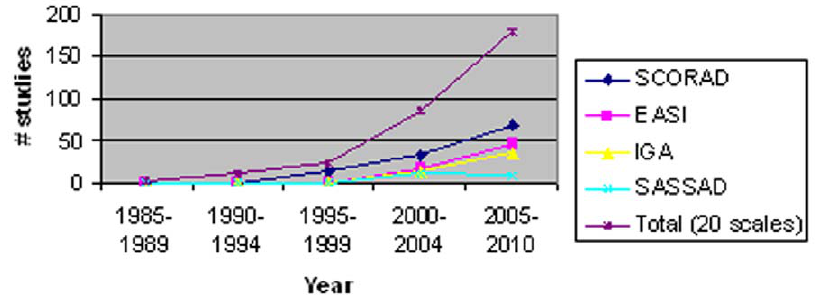
Figure 2. Trends in Disease Severity Instruments 1985–2010. doi:10.1371/journal.pone.0017520.g002 PLoS ONE |